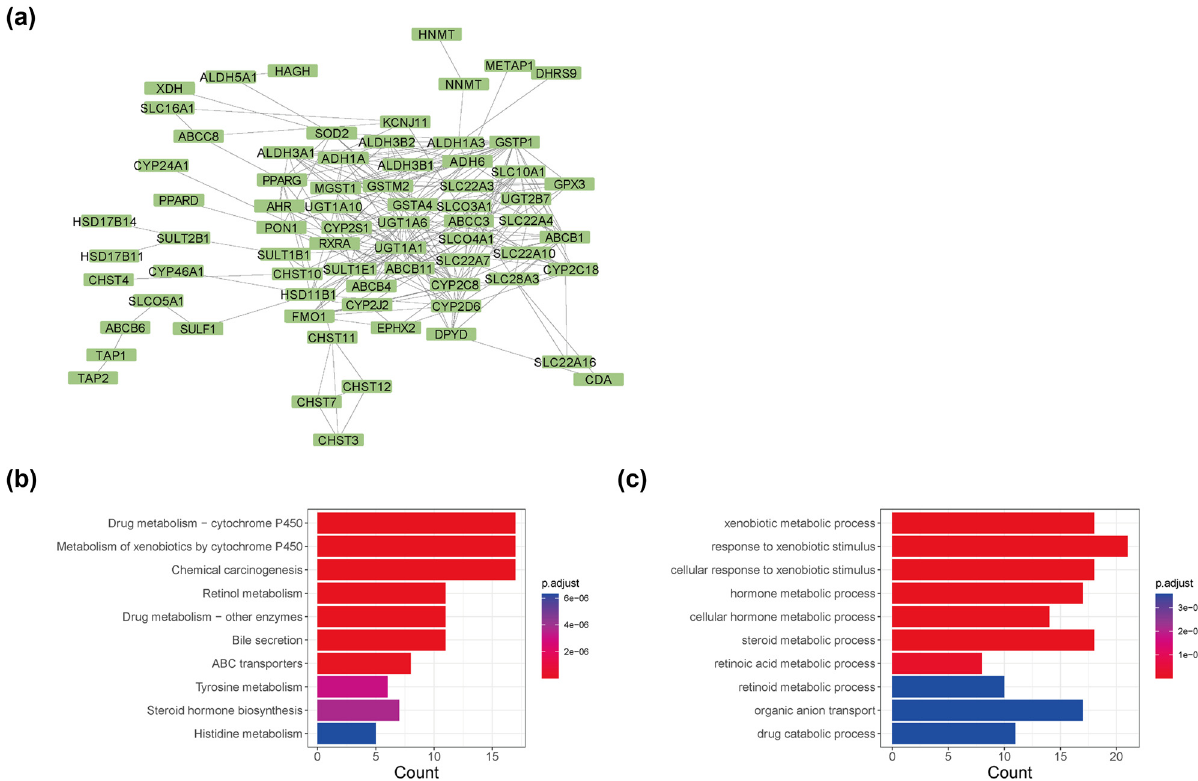
Figure 1: Protein – protein interaction network ( PPI ) and enrichment analysis of 83 drug metabolism genes: ( a ) PPI network; ( b ) enrichment results of Kyoto encyclopedia of genes and genomes ( KEGG ) ; and ( c ) enrichment results of gene ontology ( GO ) .